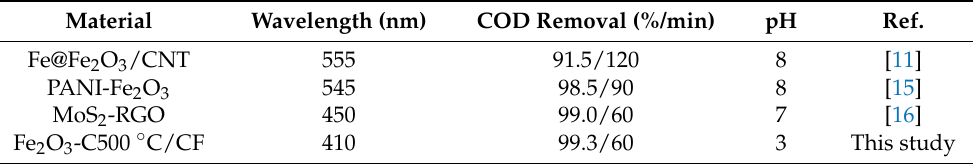
Table 2. Different kinds of photo catalyst systems employed.